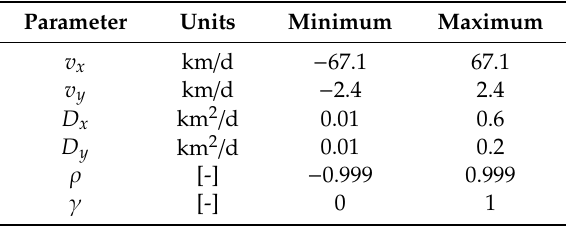
Table 1. Default parameter ranges of the Subsurface Oil Simulator (SOSim) for use in rivers. Parameter Units